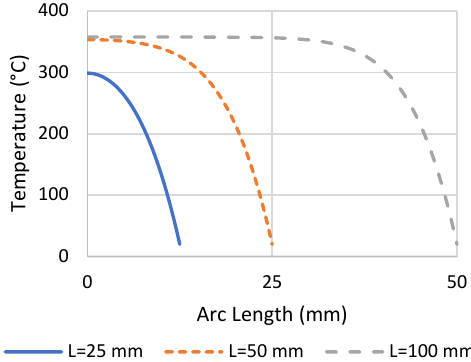
Figure 5. Summary result of gage length